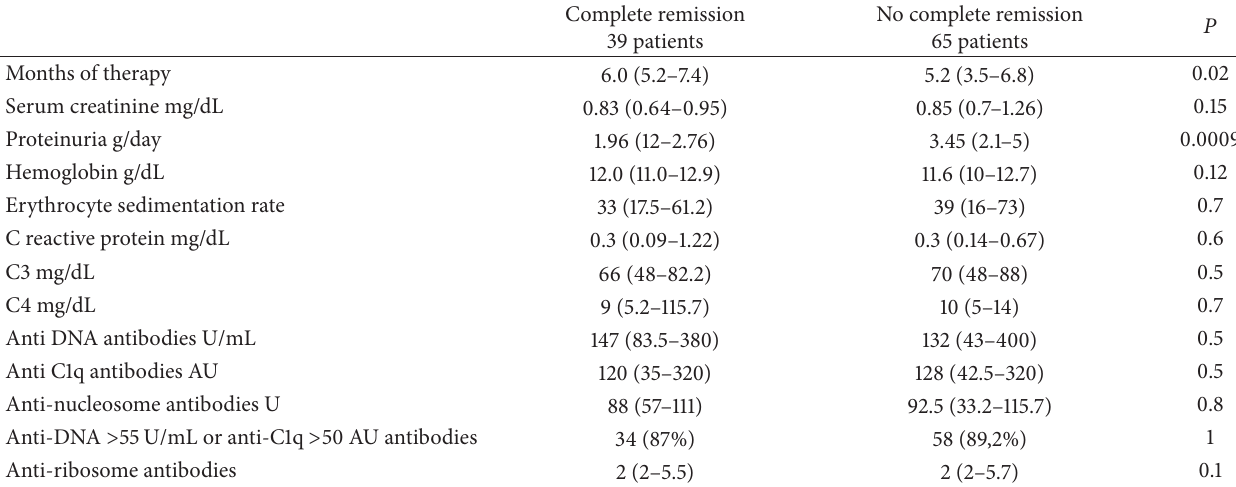
Table 5: Predictors of complete renal remissions among the clinical and the immunological tests at renal